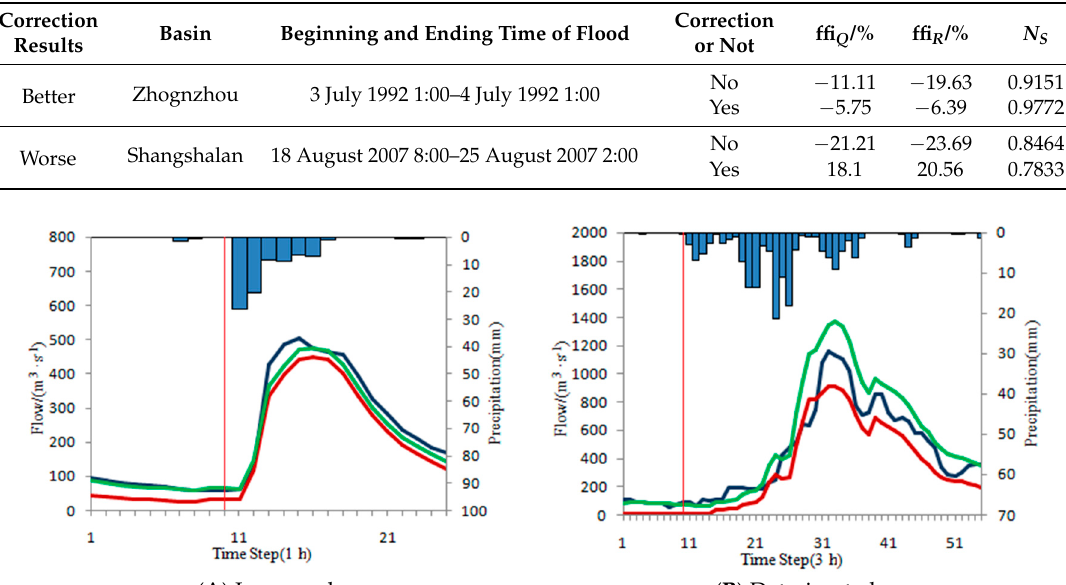
Table 15. Statistics of correction results of over-estimated floods in each basin. Basin